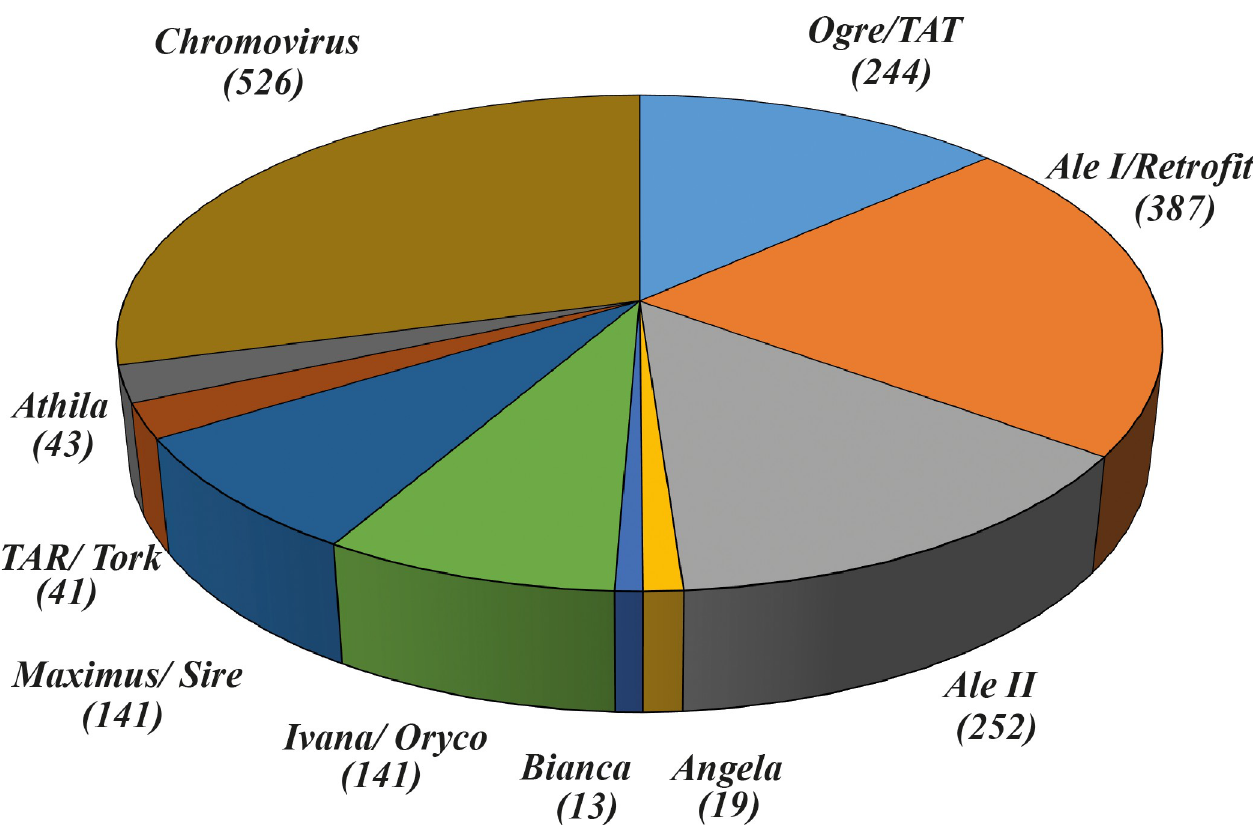
Fig 1. Composition of the library of long terminal repeat-retrotransposon reverse transcriptase sequences of sunflower.